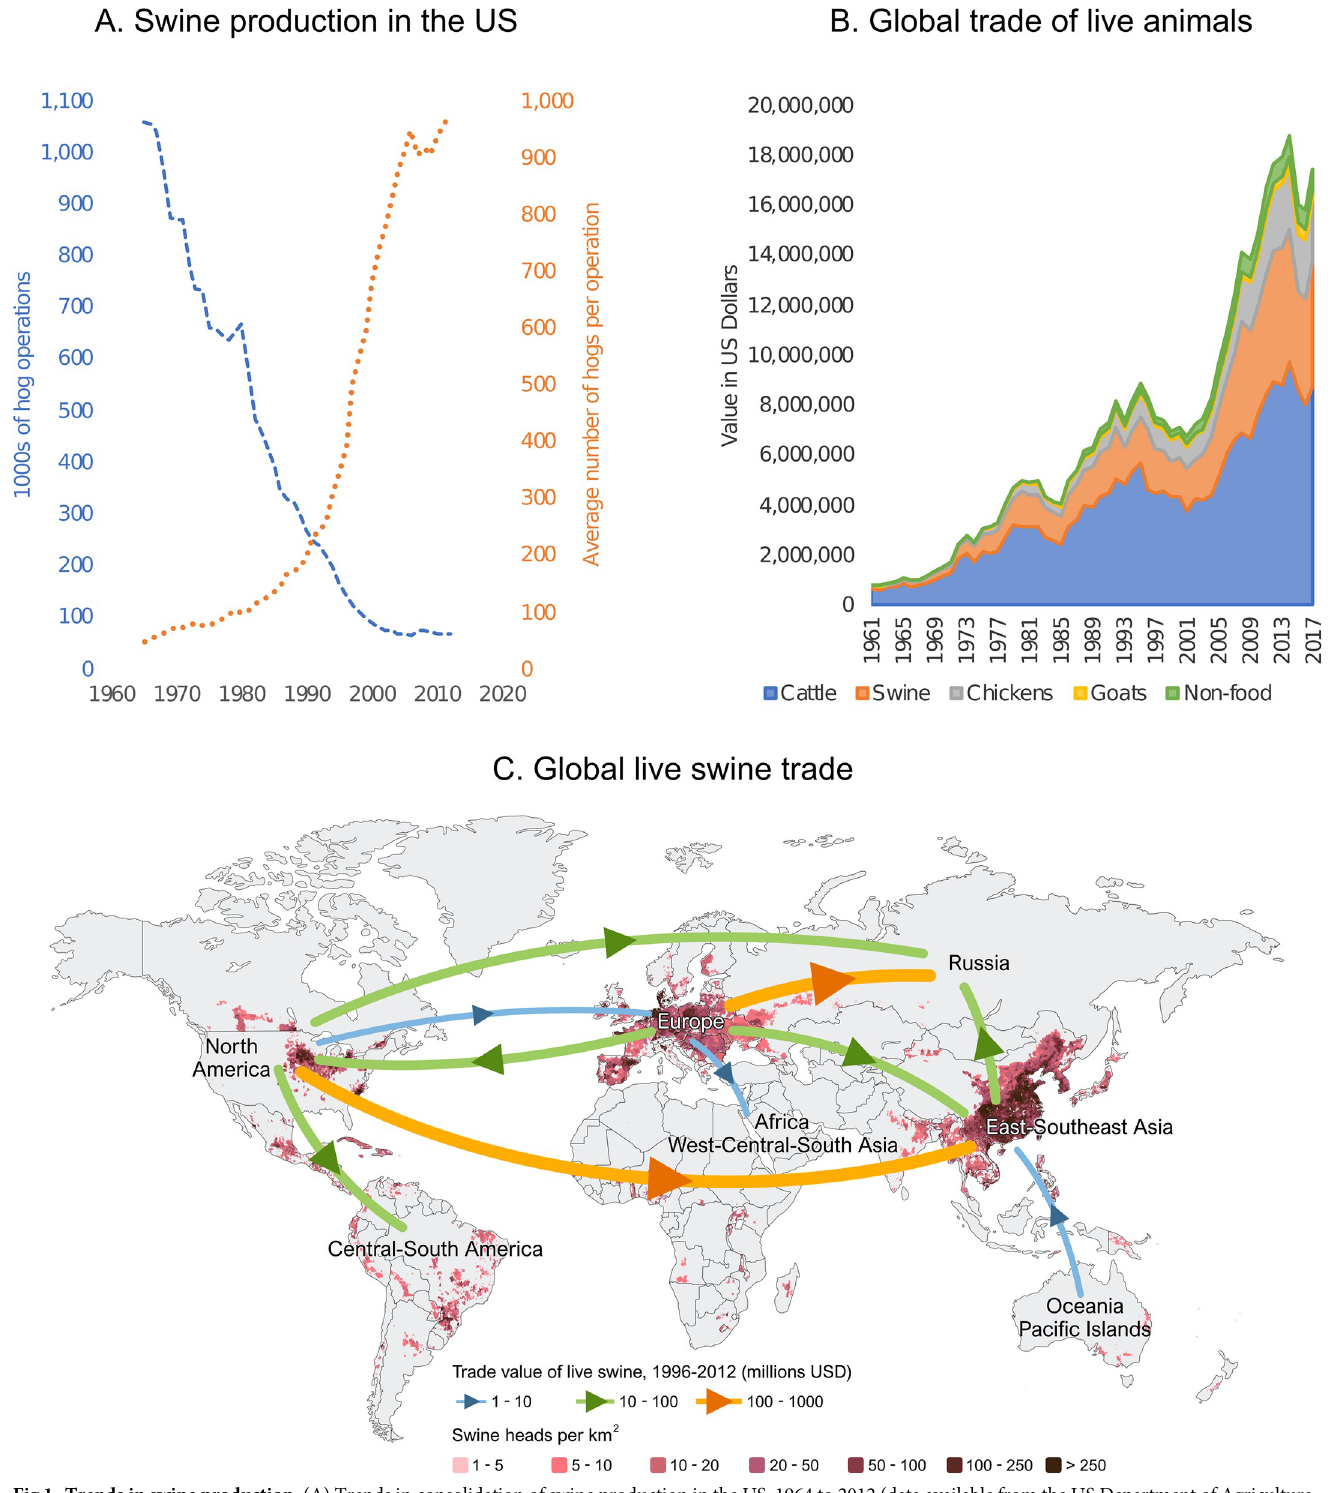
Fig 1. Trends in swine production. (A) Trends in consolidation of swine production in the US, 1964 to 2012 (data available from the US Department of Agriculture and the National Agricultural Statistics Service Quick Stats Database). (B) Growth of global trade (US$) of live animals between all countries, 1961 to 2017 (data available from FAOSTAT). (C) The global distribution and density of swine populations (approximately 1 billion animals) is depicted by points shaded along a gradient from light red (1 to 5 swine per km 2 ) to black (more than 250 swine per km 2 ). Lines with arrows depict the direction and volume of routes of trade (US$) of